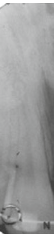
Figure 6: Radiographic view of the upper left central incisor after endodontic treatment.